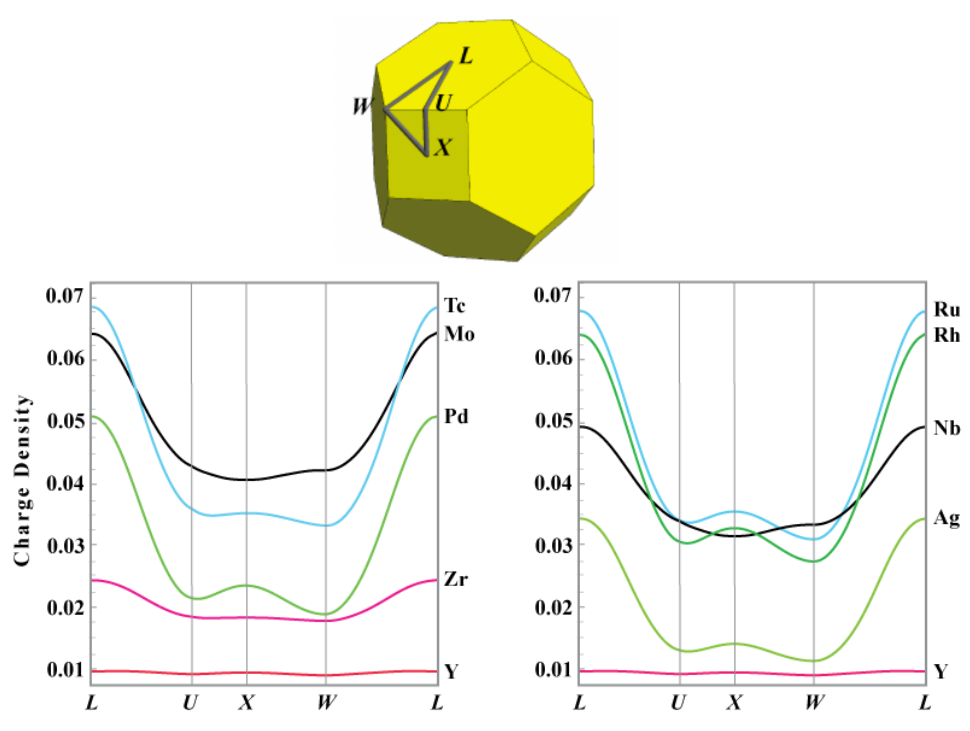
Figure 4. The electron density in AU using the LASTO software package for the 4 d transition metals around the L–U–X–W–L loop. Only for Mo and Nb (representative of the non-magnetic BCC metals) is the electron density at the W point other than a minimum around this circuit. The graphs were divided into two sets to enhance readability. Lattice constants provided in Table